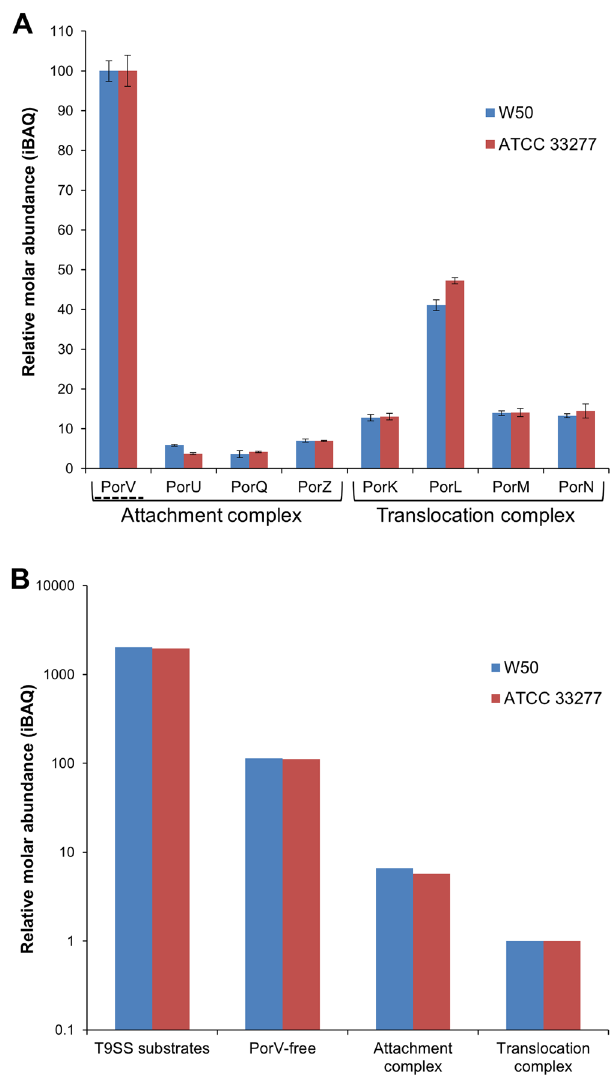
Figure 8. Stoichiometry of the proteins and complexes involved in substrate delivery. Whole cell lysates of WT strains W50 and ATCC 33277 were digested with trypsin and analysed by LC-MS/MS. Three replicate injections were analysed and quantitated using MaxQuant software. The iBAQ metric was used as an estimate of the relative molar abundance of each protein. ( A ) Relative abundance of components plotted on a linear scale with the abundance of PorV set to 100 for each strain. Error bars represent the standard deviation of the mean. PorV is mostly free with only a small portion present in the attachment complex. ( B ) Relative abundance of protein complexes plotted on a logarithmic scale. The translocation complex comprising PorK, PorL, PorM and PorN was set to a relative abundance of 1 based on the average iBAQ values of PorK, PorM and PorN. The iBAQ values of the other three categories were multiplied by 16 relative to the translocation complex to account for the differing number of subunits. The value of the attachment complex was taken as the average of the values for PorU, PorQ and PorZ. This value was then subtracted from the total PorV to give the value of free